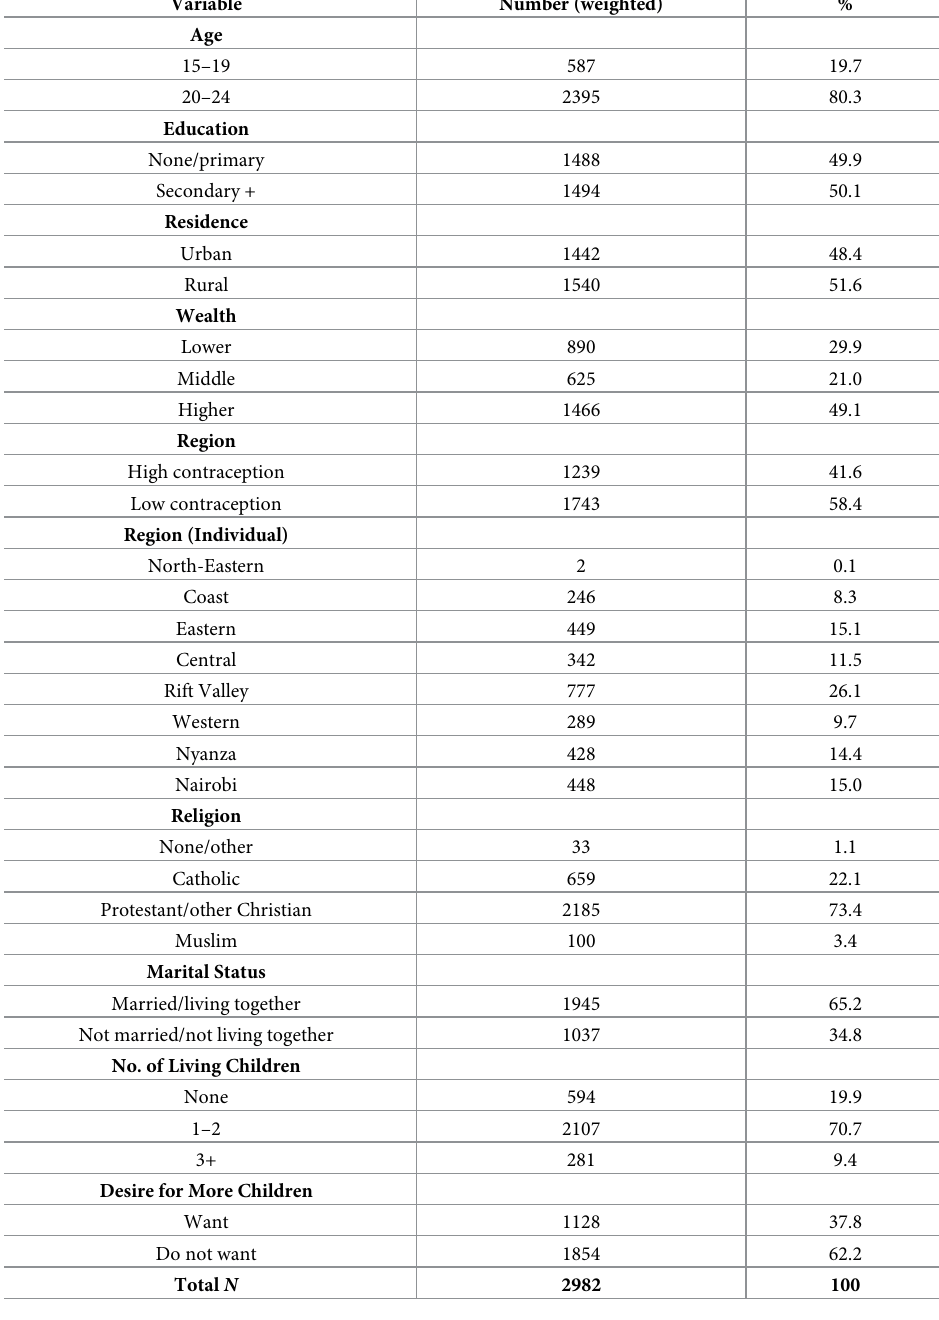
Table 1. Distribution of women aged 15–24 using modern methods of contraception in Kenya, 2014 via back- ground